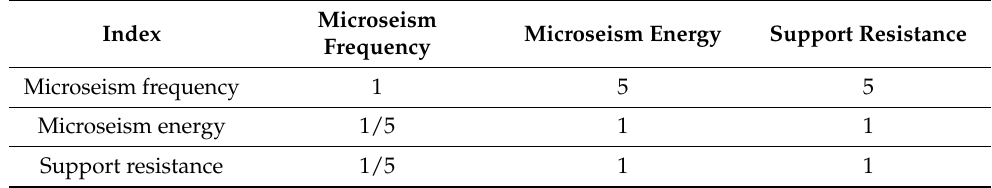
Table 4. Judgment matrix of each index.